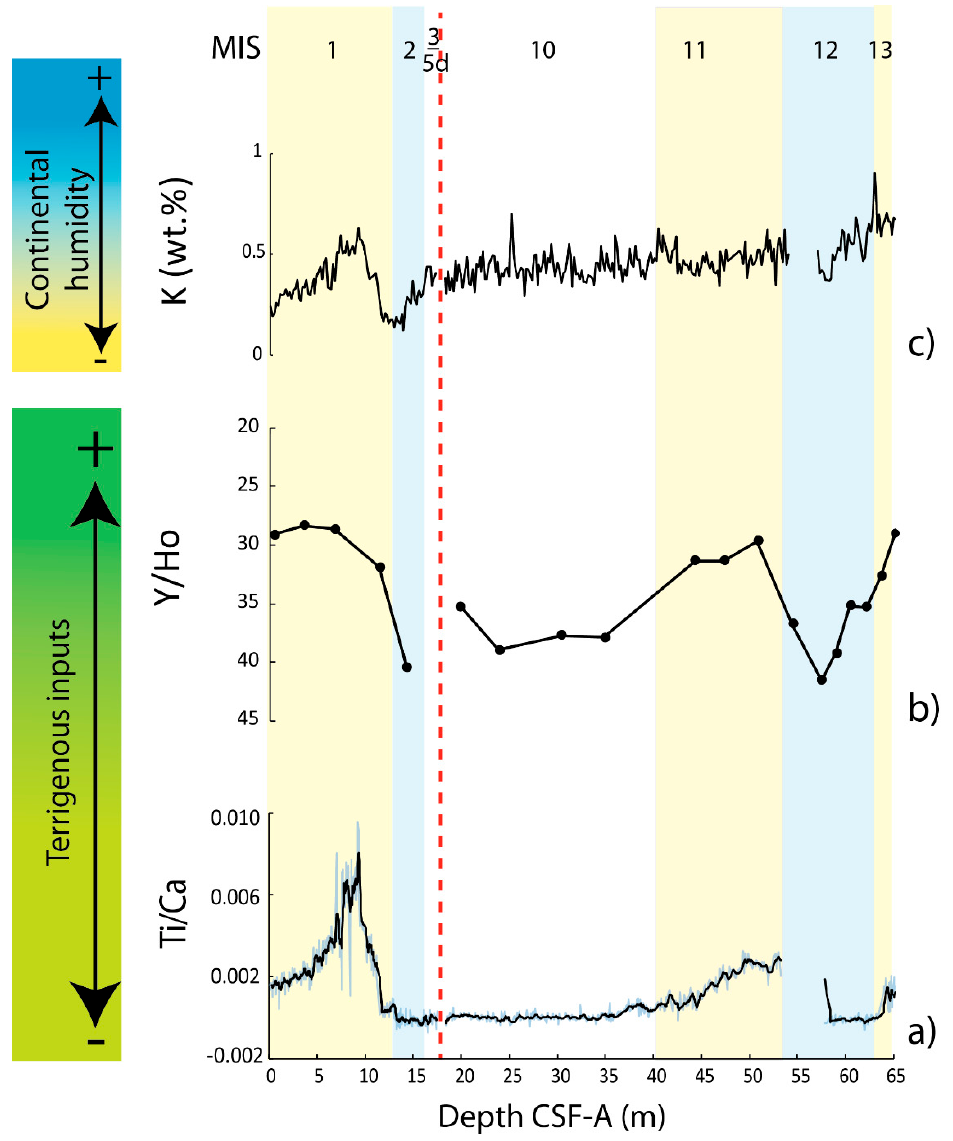
Figure 5. Proxies to trace the terrestrial versus fluvial inputs. ( a ) Ti / Ca ratio, ( b ) Y / Ho ratio, and ( c ) K% (wt.%). Black line is the moving average with a period of 5 for ( a ).